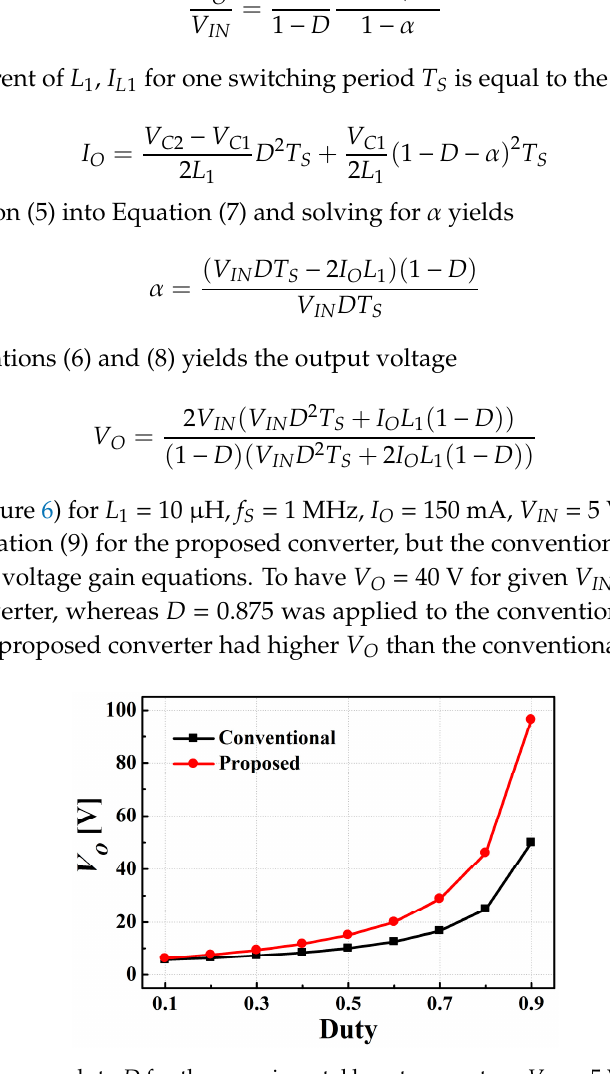
Figure 6. V O versus duty D for the experimental boost converters; V IN = 5 V , 0.1 ≤ D ≤ 0.9 .